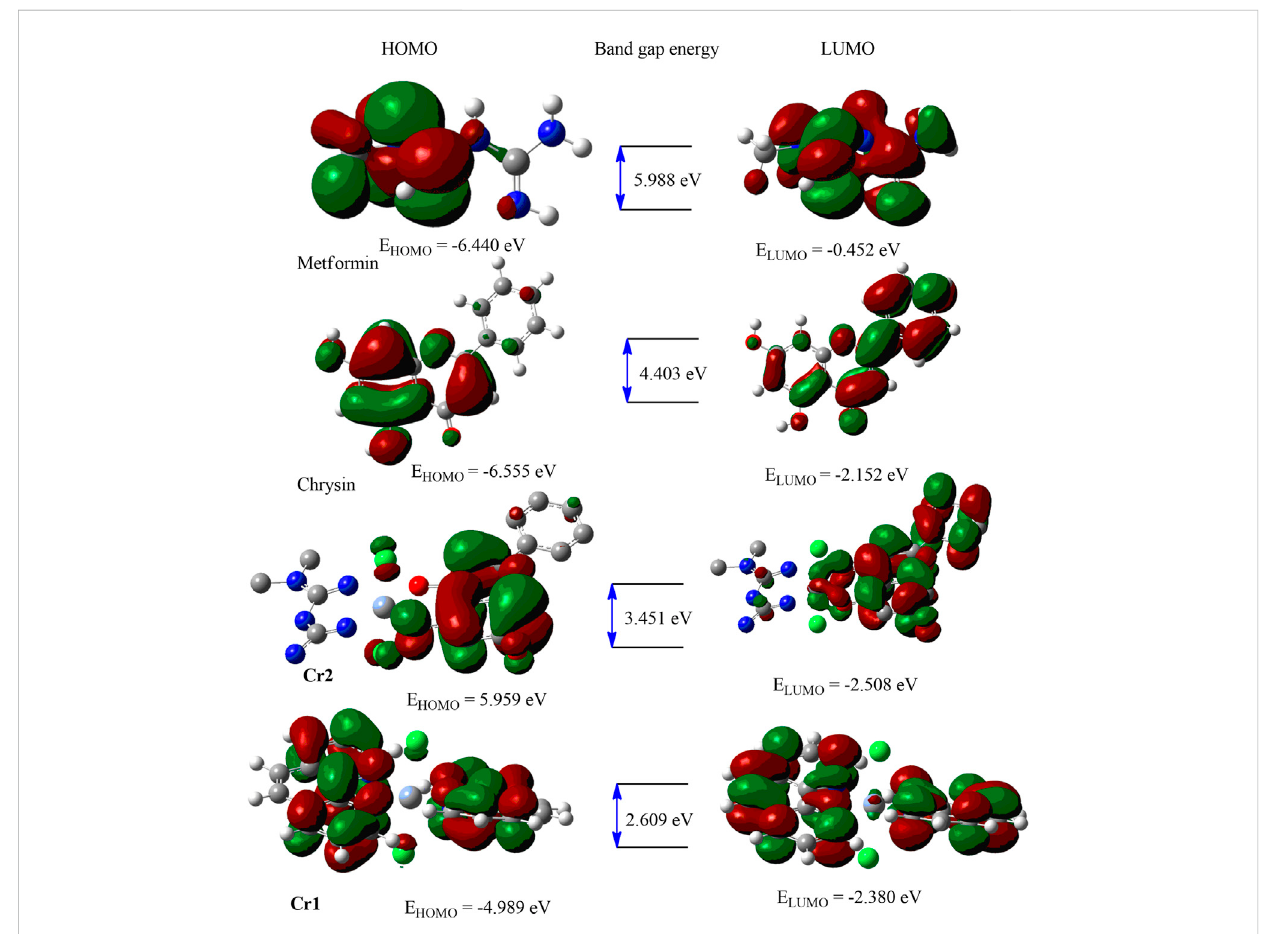
FIGURE 5 HOMO – LUMO distributions of the ligands and metal